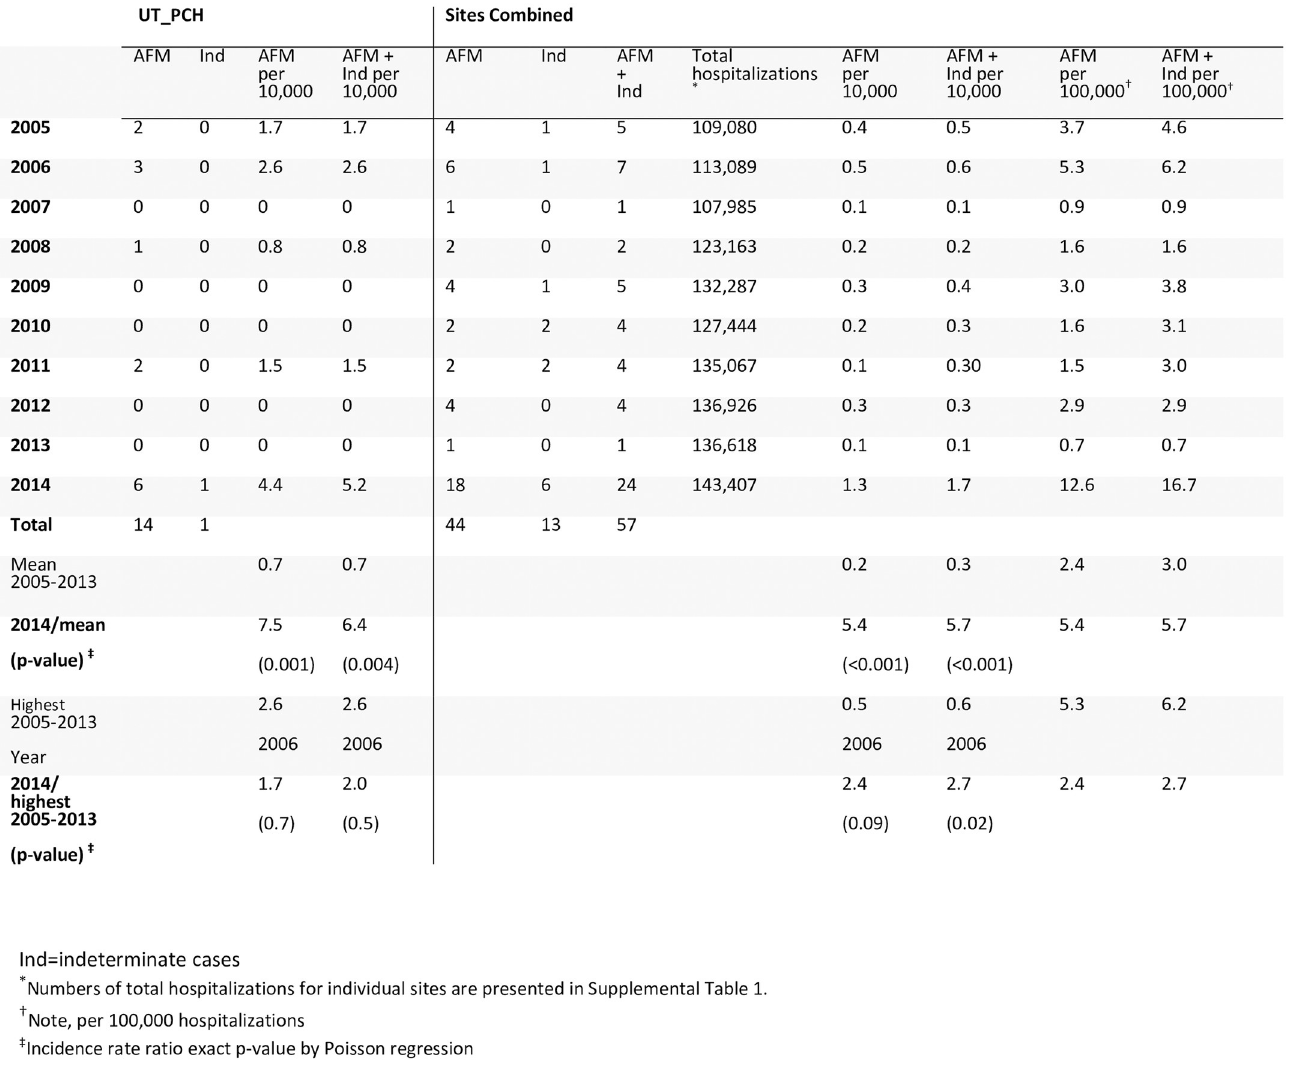
PLOS ONE | https://doi.org/10.1371/journal.pone.0228671 February 13,